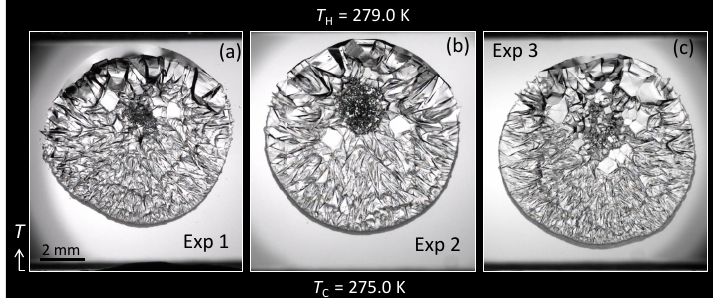
Figure 4. Detail of methane hydrate morphology on an aqueous MEG solution droplet subject to a temperature gradient. w MEG = 10%, p = 5.99 MPa, T L = 275.0 K, T H = 279.0 K, and T HLV = 279.7 K. ( a ) Large faceted crystals at the droplet boundary. ( b ) Small faceted crystals inside the droplet. ( c ) Smaller crystals.